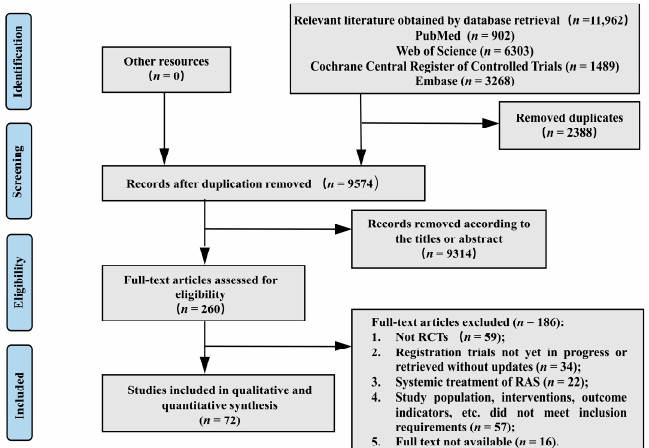
Figure 1. Flow chart of the study selection process.